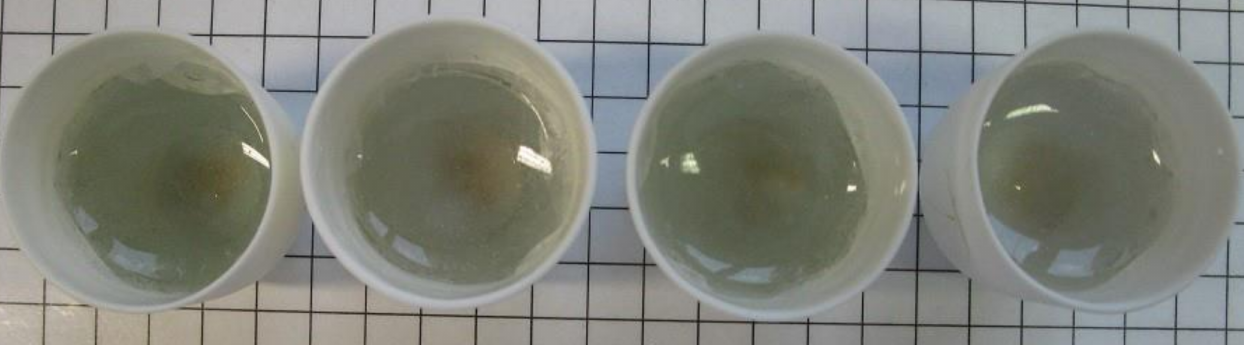
Figure 4. Melts after completion and cool down of the melting process. From left to right A, B, C and